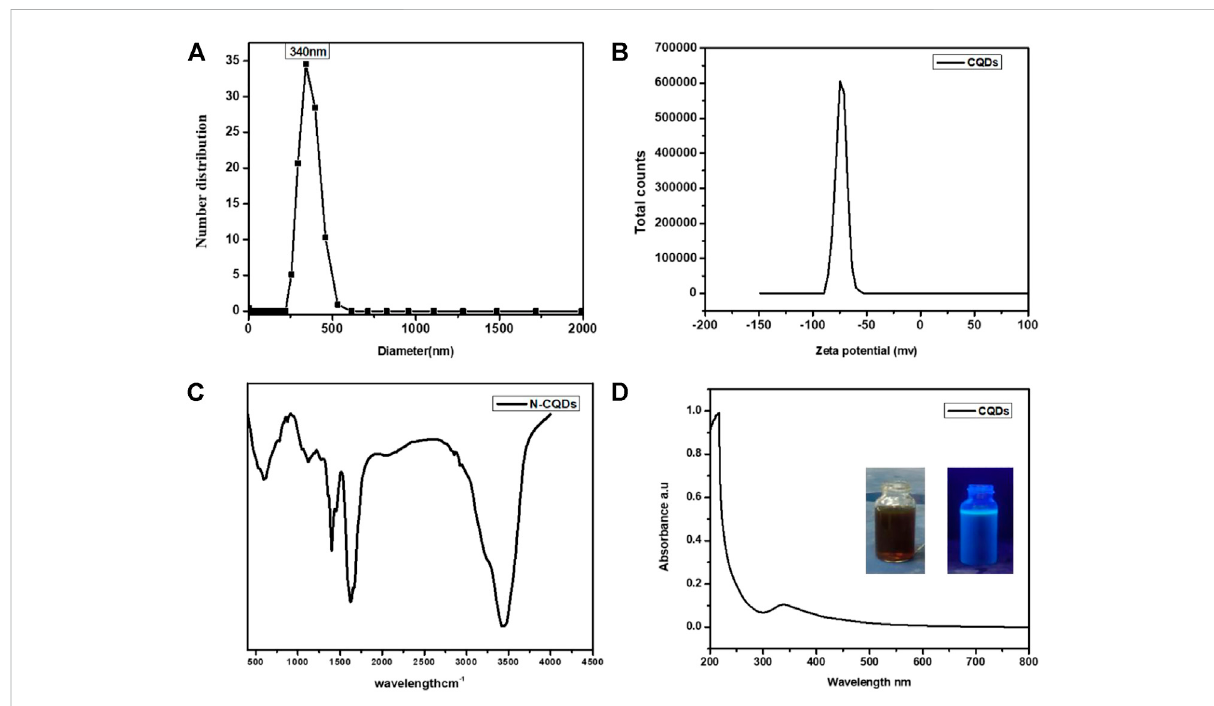
and PAN/GO/CQDs composite nano fi bers. SEM in Figure 4A veri fi ed the highly expanded and porous structure of graphite. After chemical treatment and thermal heating, it collapsed the graphite layer and deformed the structure randomly, resulting in high porosity and smoothness in the structure. Figures 4B and C show SEM of PAN nano fi bers (b) without coating and (c) with coating, demonstrating fi ne, diameter in nm and clear difference with pristine PAN